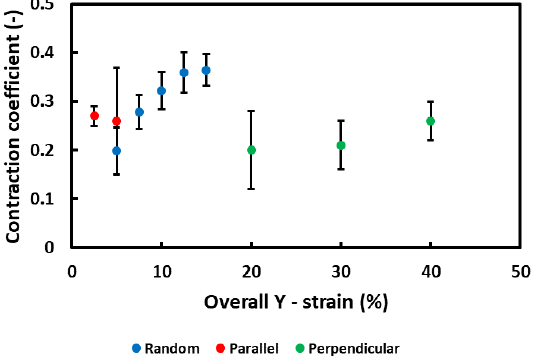
Figure 4. Contraction coefficient of the three different nanofiber membranes as a function of the strain. The contraction coefficient was measured based on the change in length between features in the membrane (multiple measurements on a single specimen).